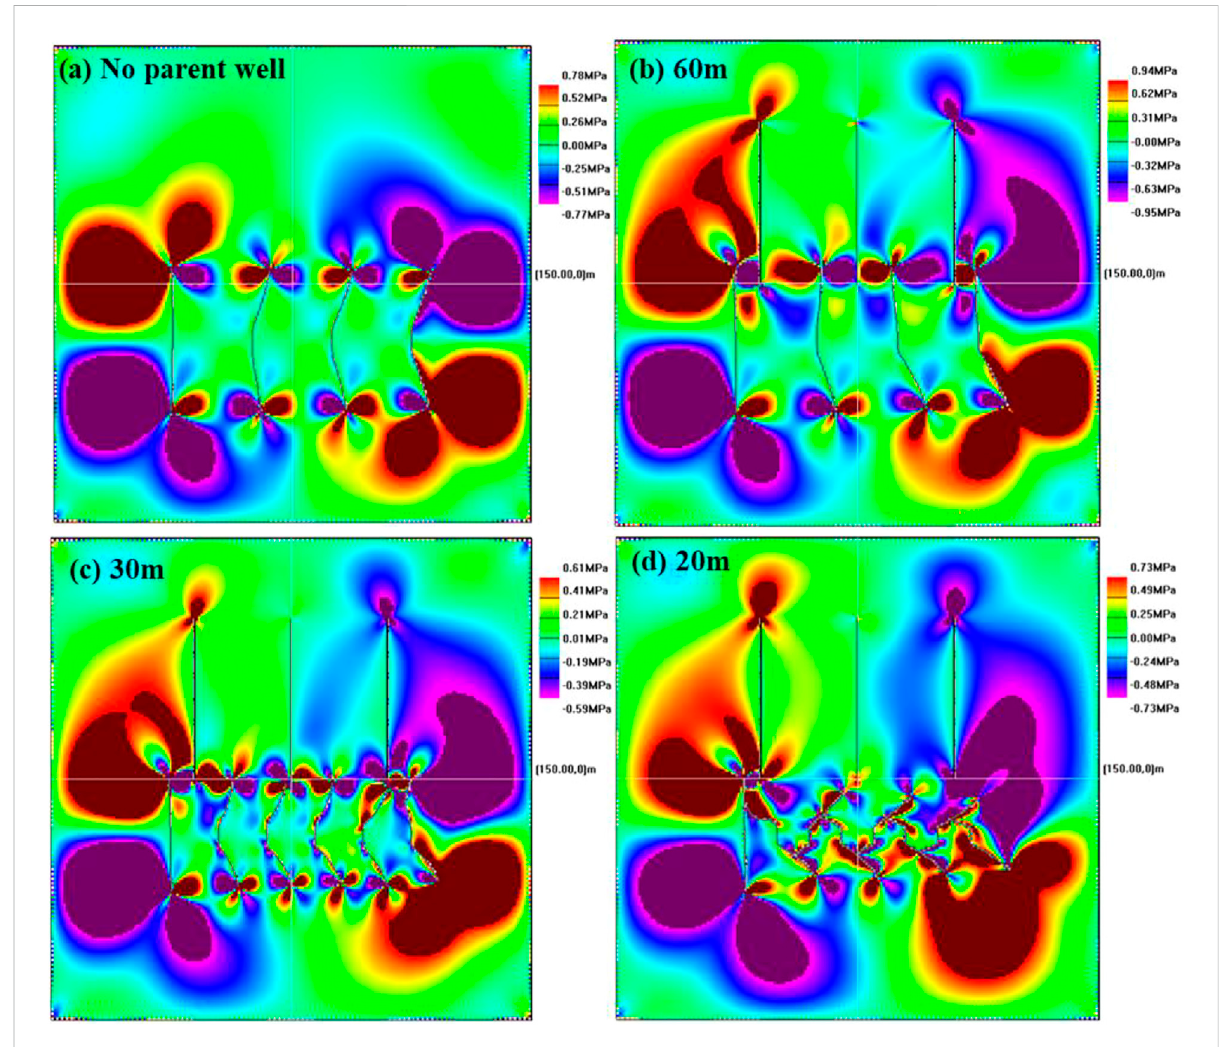
FIGURE 11 Distribution of shear stress fi eld around arti fi cial fractures with different fracture spacings.